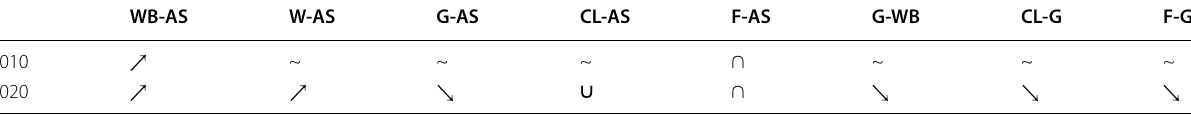
“ ↗ ” stand for a positive contribution; “ ↘ ” stand for a negative contribution “ “represent a U-shaped contribution; “ ∩ “represent an inverted U-shaped contribution ∪ “~” indicates the SHAP value fluctuates around 0